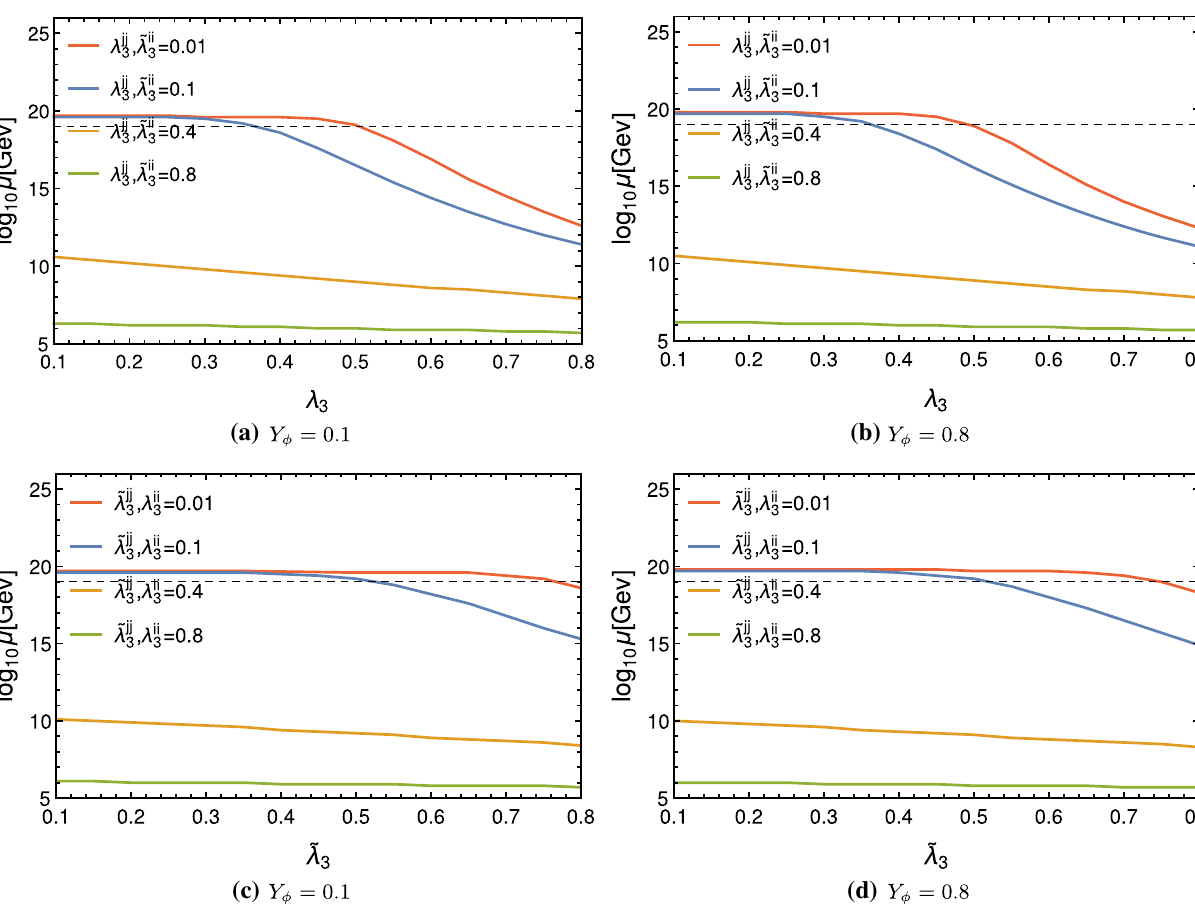
is depicted while symbolizing the same for the remaining generations by (cid:2) λ jj . The other quartic coupling λ ii includes all three generations of 3 3 leptoquark. The variations are considered for four different initial val- ues, i.e. 0.01, 0.1, 0.4 and 0.8, at EW scale, which are described by red, blue, orange and green curves, respectively. Here, two different values include all three 3 for Y φ are considered, which are 0.1 and